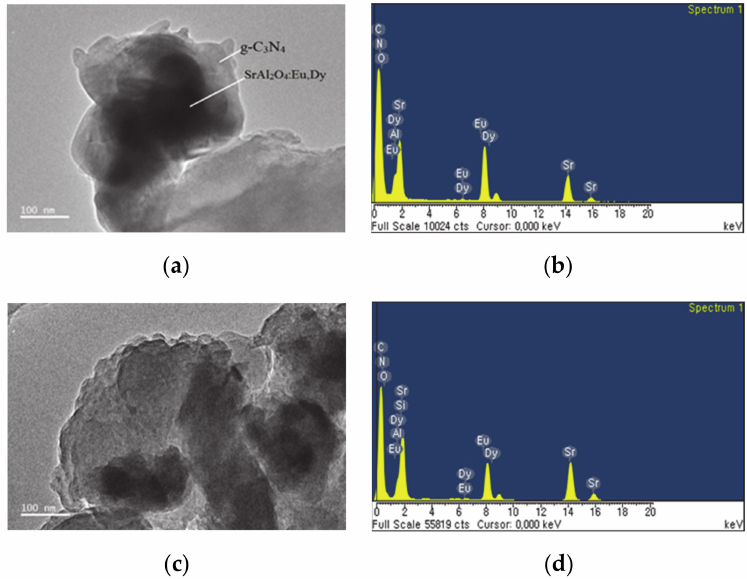
Figure 3. TEM images ( a , c ) and EDS spectra ( b , d ) where ( a , b ) is SrAl 2 O 4 :Eu,Dy / 50 wt.% g-C 3 N 4 and ( c , d ) is 50 wt.% g-C 3 N 4 supported on SrAl 2 O 4 :Eu,Dy-0.01M SiO 2